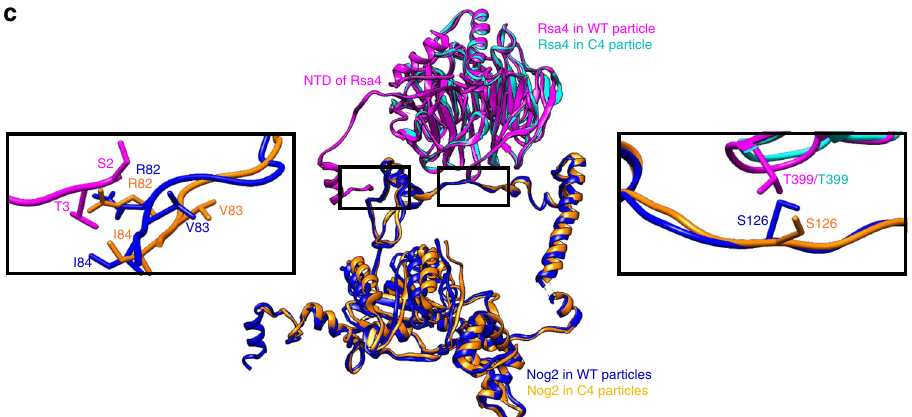
Fig. 7 The NTD of Rsa4 is invisible, and likely fl exible in the C4 class of rpf2 Δ 255-344 . a The subunit interface view of density maps from the wild-type RPF2 and the C4 class of rpf2 Δ 255-344 mutant particles. Densities for Rsa4 were colored using Color Zone in Chimera. b Atomic models for Rsa4 from the wild-type and C4 class of the rpf2 Δ 255-344 mutant were fi tted into density maps of the wild-type and the C4 class mutant. The fi rst 34 amino acids of the NTD of the Rsa4 are fl exible and invisible in the absence of the CTD of Rpf2. c Atomic models for Rsa4 and Nog2 from the wild-type and the C4 class are colored and labeled. For clarity, only relevant side chains are shown. Conformational changes in Nog2 may affect Rsa4, because Nog2 and Rsa4 are in close contact at two points (rectangles): at the NTD and the globular domain of Rsa4. Enlarged rectangles show contact points between Rsa4 and